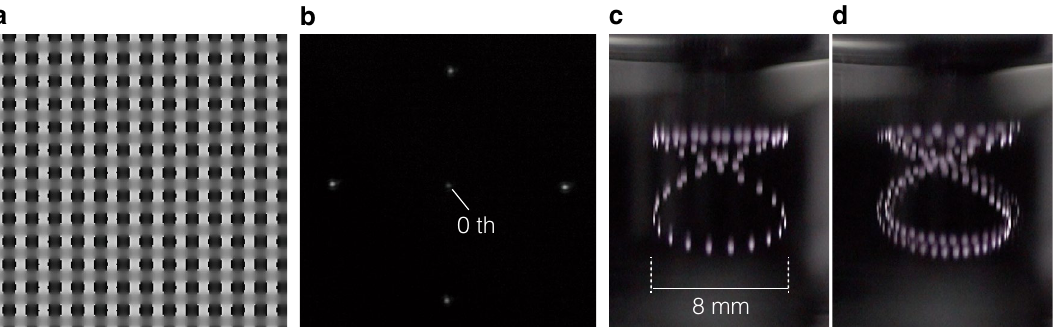
Figure 6. Parallel voxel generation via the CGH. ( a ) CGH calculated for a target pattern of four focal points designed to have a maximum spatial frequency ν = 4 lp/mm. ( b ) Focal points generated in parallel by a lens with a focal length of 200 mm captured by a CCD image sensor. Volumetric Lissajous figures drawn with ( c ) a single focal point and ( d ) four focal points generated in parallel. These images were generated in a Xe-filled glass cell and captured in the form of movies at 20